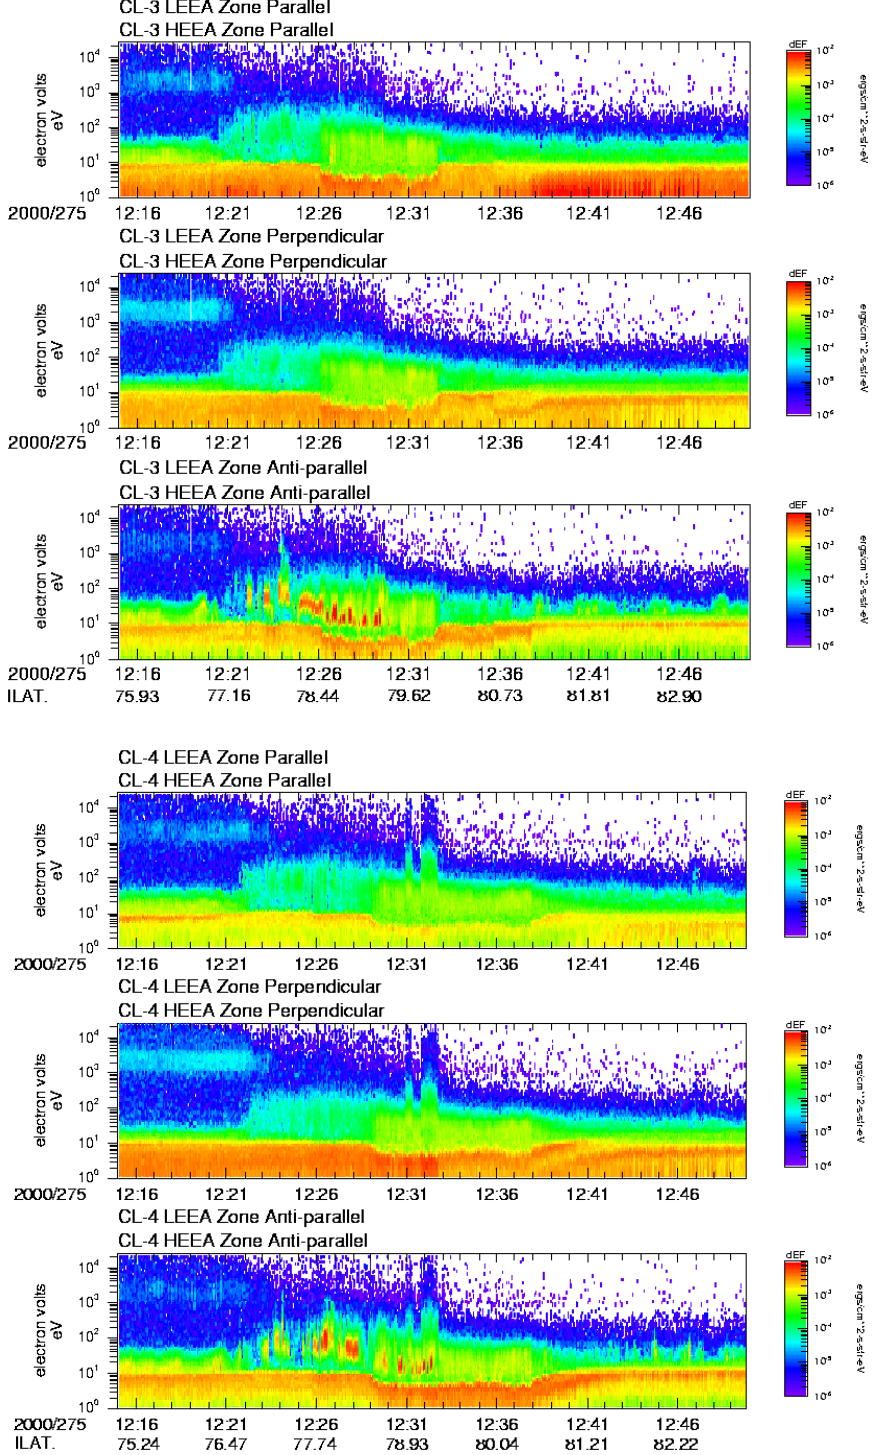
Fig. 2. Electron energy-time spectrograms generated from LEEA and HEEA sensors depicting field-aligned, perpendicular and field opposed electrons, (a) shows Cluster 3 data and (b) shows Cluster 4